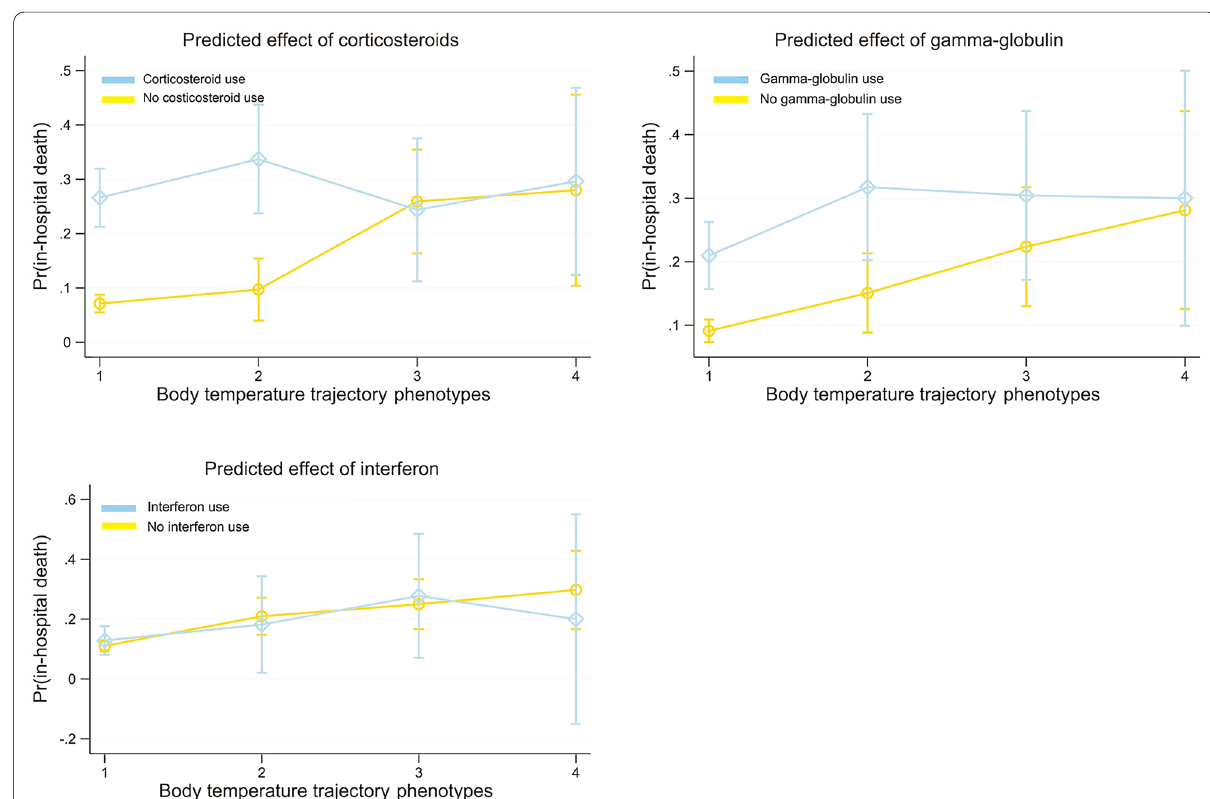
Three logistic models were used to evaluate the association between in-hospital death and four body temperature trajectory groups. Compared to the normothermic group, there was a trend toward increasing risk of in-hospital death from fever, fast resolvers to fever, and slow resolvers. Bootstrapping (1000 resamples) were used for calculating 95% CI in Model 3 and the results remained stable